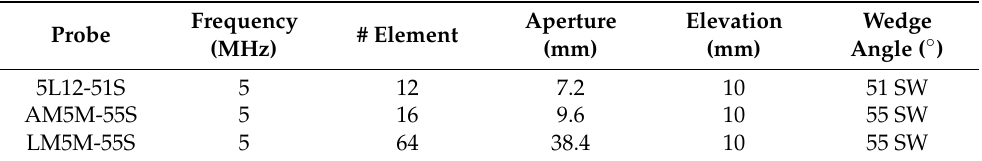
Figure 3. Sectorial scanning from both blade surfaces. Table 1. Used PAUT probes. Table 1. Used PAUT